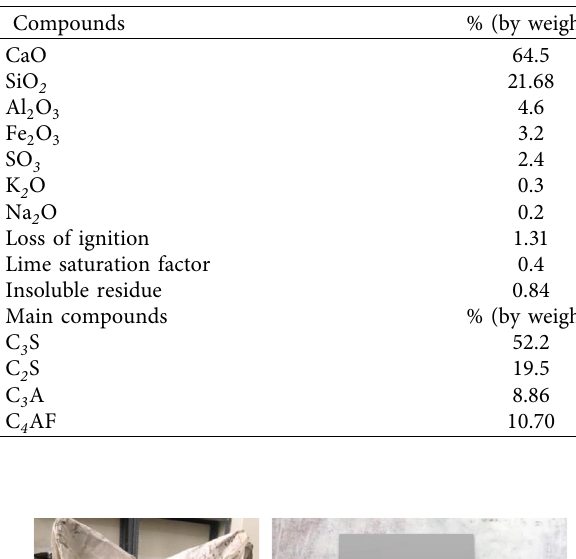
Figure 1: Flow chart of the experiment. Table 1: Mechanical properties of cement Table 2: Chemical properties of cement [51].